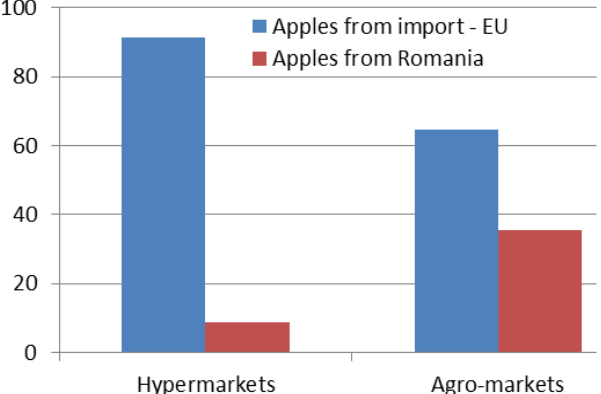
Fig. 3. The origin and distribution of apples in Cluj-Napoca (Romania vs. EU, markets vs. hypermarkets) (based on data registered during January-March for two consecutive years)